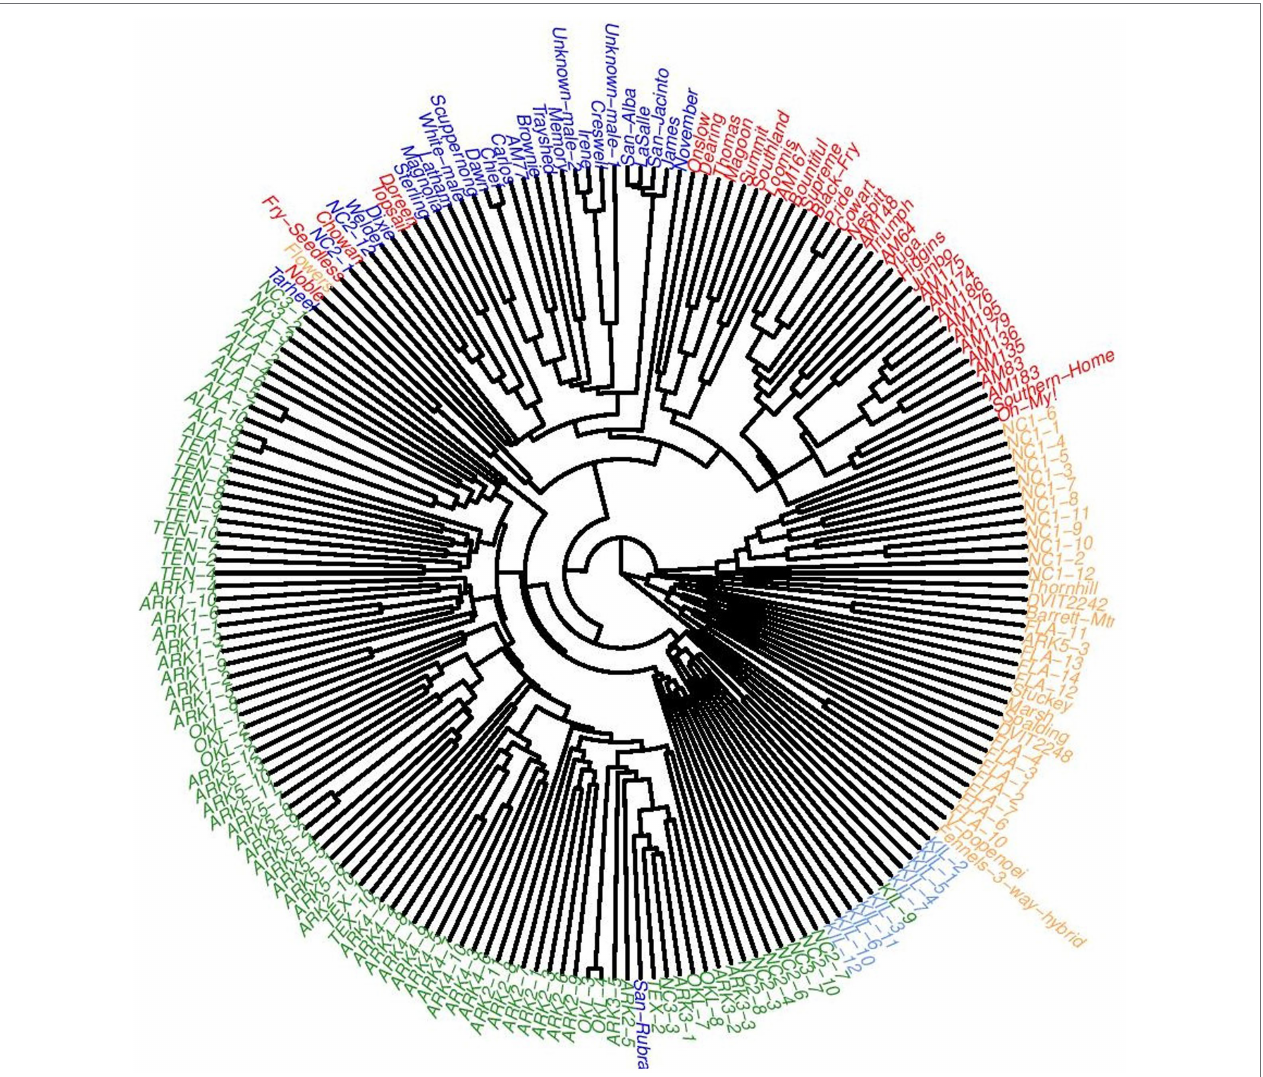
FIGURE 5 | Unweighted pair group method with arithmetic mean (UPGMA) tree of all 194 accessions used in this study colored according to which cluster they were majority assigned to at K =